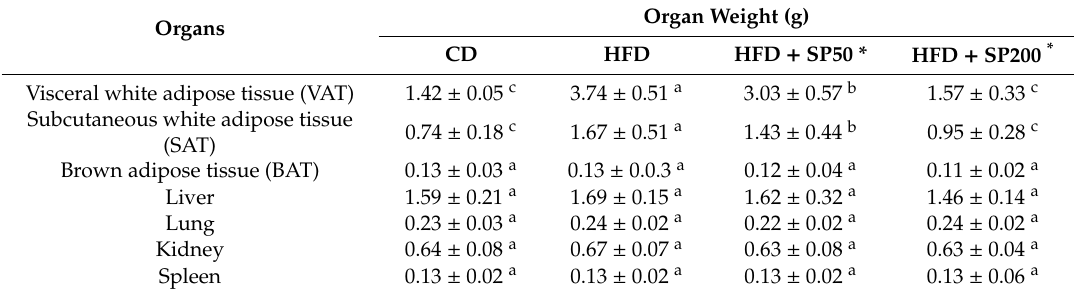
Figure 1. E ff ect of silk peptide consumption on the development of high-fat diet-induced obesity in mice. ( A ) Weekly body mass measurements and ( B ) body mass gain of mice treated for 6 weeks. ( C ) Representative photographs of the mice. ( D ) E ff ect of silk peptide (SP) on visceral adipose tissue (VAT) mass in chow diet (CD)- and high-fat diet (HFD)-fed groups. Serum ( F ) total cholesterol and ( E ) triglyceride concentrations were measured using colorimetric kits. ( G ) Food intake and ( H ) water consumption per unit body mass. Data are expressed as the mean ± SD ( n = 8). Values with di ff erent letters are significantly di ff erent; p < 0.05 (a > b > c). Table 1. E ff ect of SP treatment on organ weight in HFD-fed mice for 6